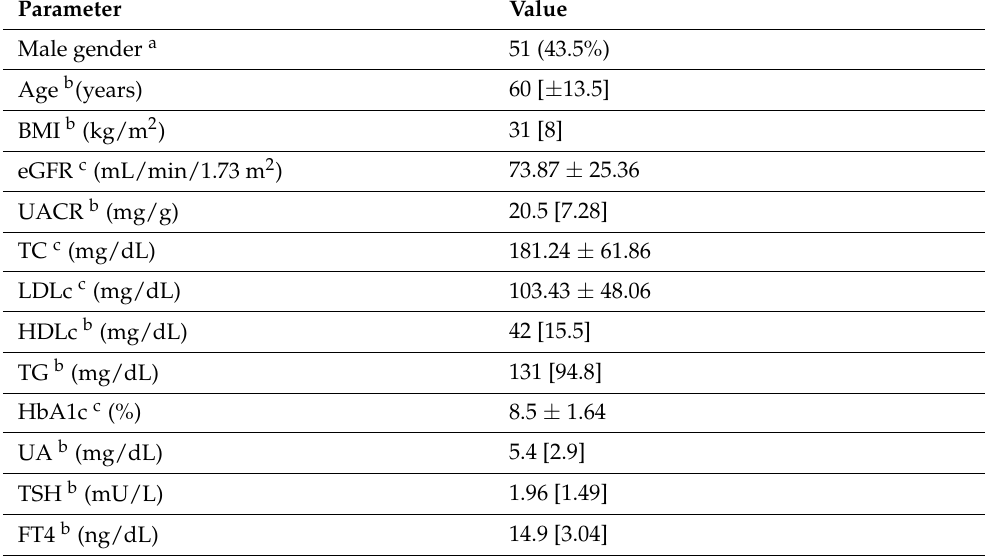
Table 1. Patients’ general characteristics at